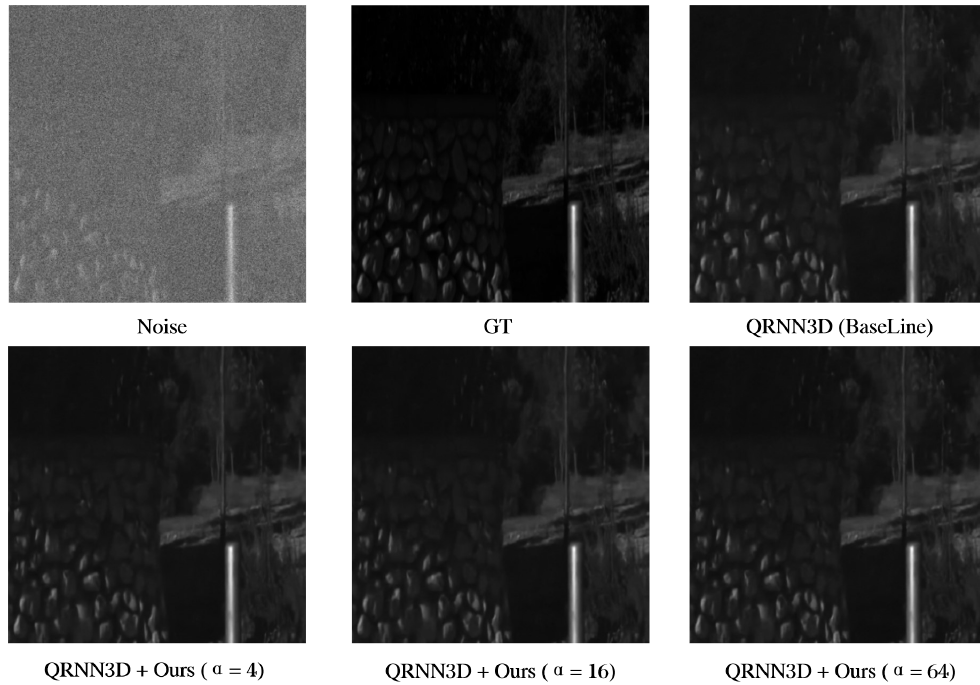
Figure 16. The impact of the total number of patches on the network performance.